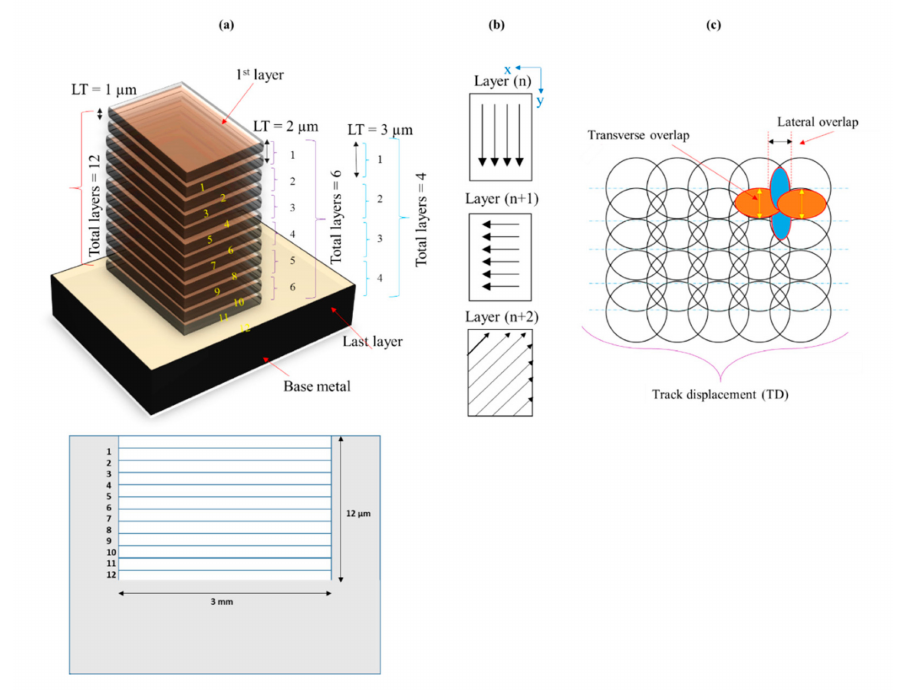
Figure 1. Schematics of laser milling phenomenon for micro-impressions; ( a ) number of layers against di ff erent layer thickness values, ( b ) mode of scanning cycle, and ( c ) pulse overlap in terms of track